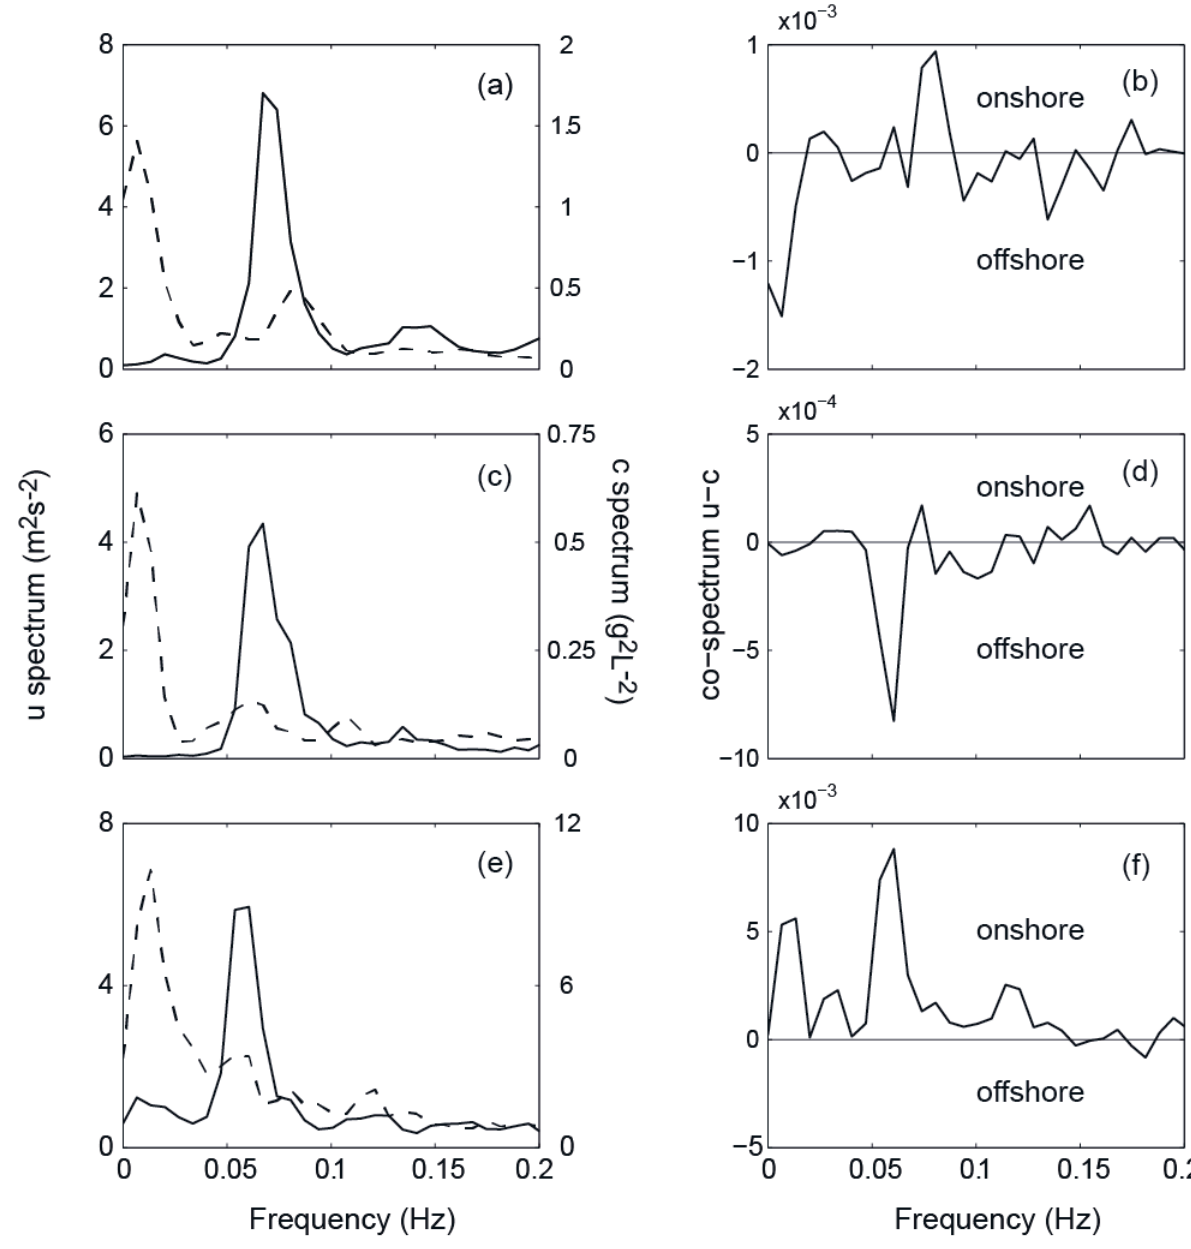
The the swell band (frequency > 0.04 Hz) was calculated for each data set, as Russell and Huntley [28] explained, and plotted with the varying tide level in Figure 9c (velocity skewness is considered positive in the onshore direction and negative in the offshore direction). The suspended sediment flux at the swell frequency band was onshore when the normalised velocity skewness was high and offshore when the skewness was low but, still positive (Figure